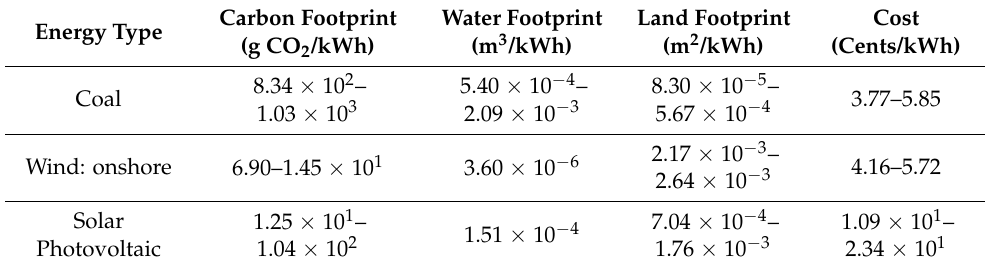
Figure 1. Total Electricity Generation, Missouri 2001–2019. Table 1. Sustainability Indicators of Various Energy Types .